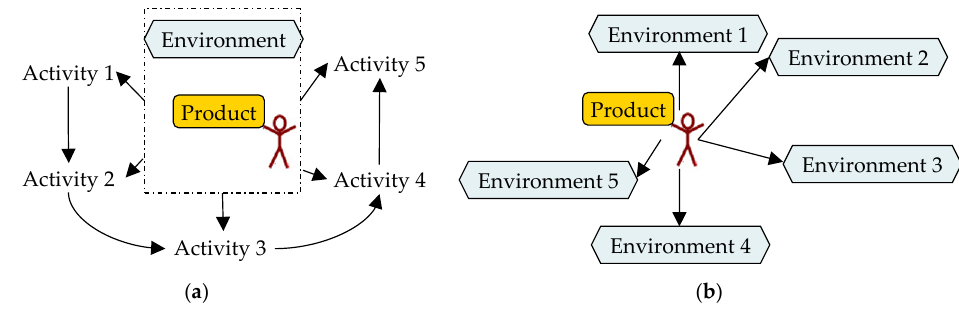
Figure 6. ( a ) The expansion of activity; ( b ) The expansion of environment. Figure 6. ( a ) Expansion of activity; ( b ) expansion of the environment.